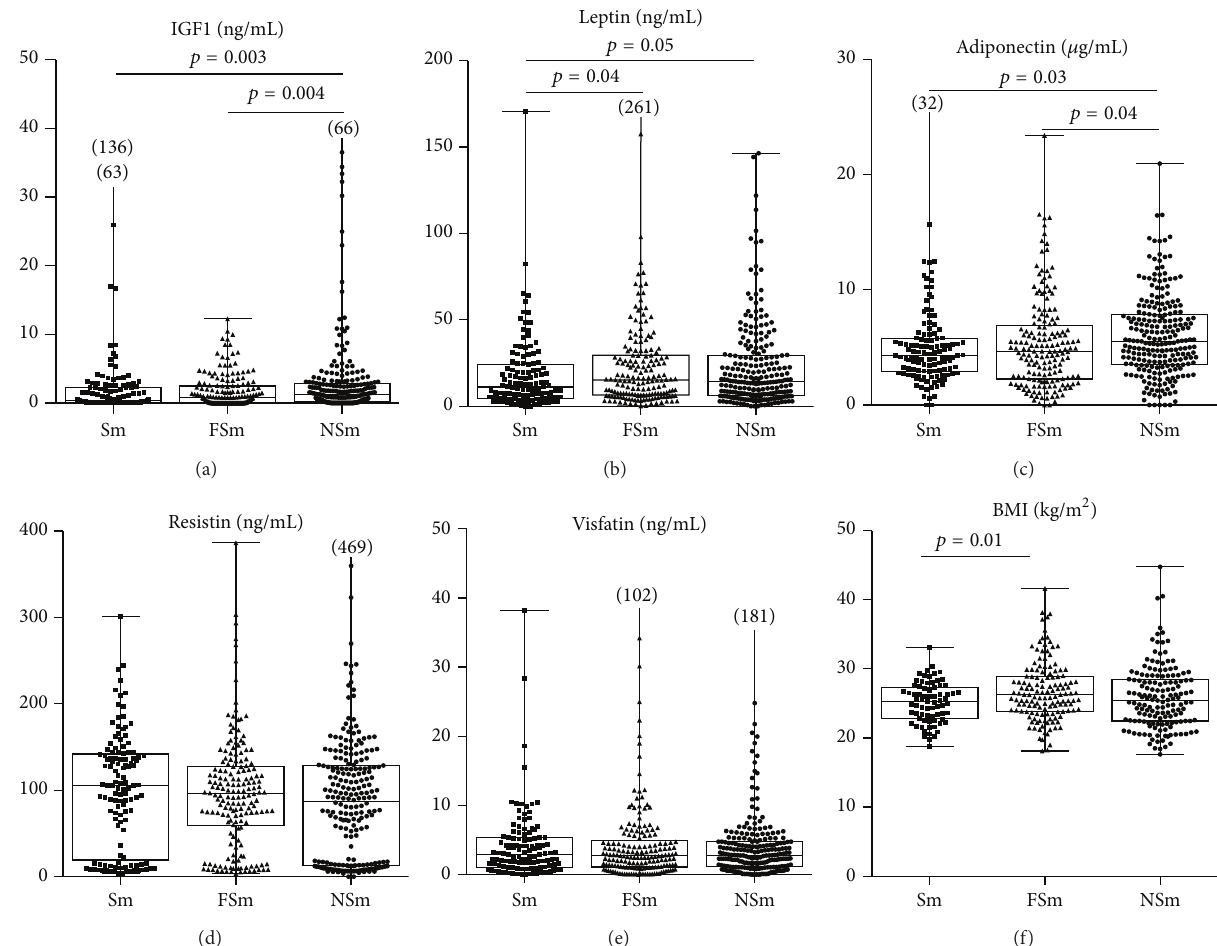
Figure 1: Serum levels of IGF1 and adipokines in RA patients grouped by smoking habits. Serum levels of IGF1 (a), leptin (b), resistin (d), adiponectin (c), visfatin (e), and BMI (f) in RA patients grouped by smoking habits in current smokers (Sm, 𝑛 = 126 ), former smokers (FSm, 𝑛 = 177 ), or never smokers (NSm, 𝑛 = 240 ). Boxes represent median and interquartile range. The comparison was performed by the Kruskal Wallis nonparametric ANOVA with Dunn’s multiple comparisons